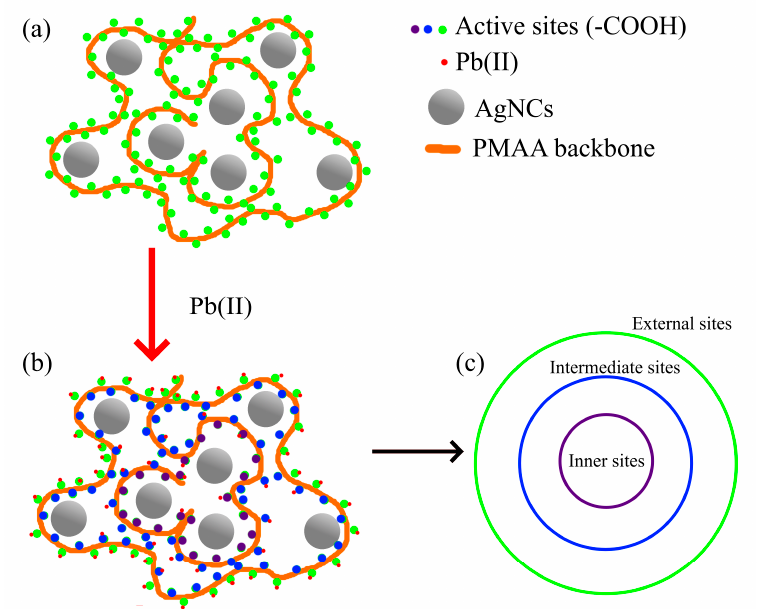
Figure 4. Schematic representation of AgNCs with active sites and hypothesis of Pb(II) adsorption process: ( a ) AgNCs (grey spheres) surrounded by PMAA chains (orange lines) before the interaction, the active sites are indicated with green spots; ( b ) the lead(II) ions (red spots) mainly interact with the external sites (green dots), and subsequently with the inner ones (blue and purple dots); ( c ) spatial differentiation of active sites.